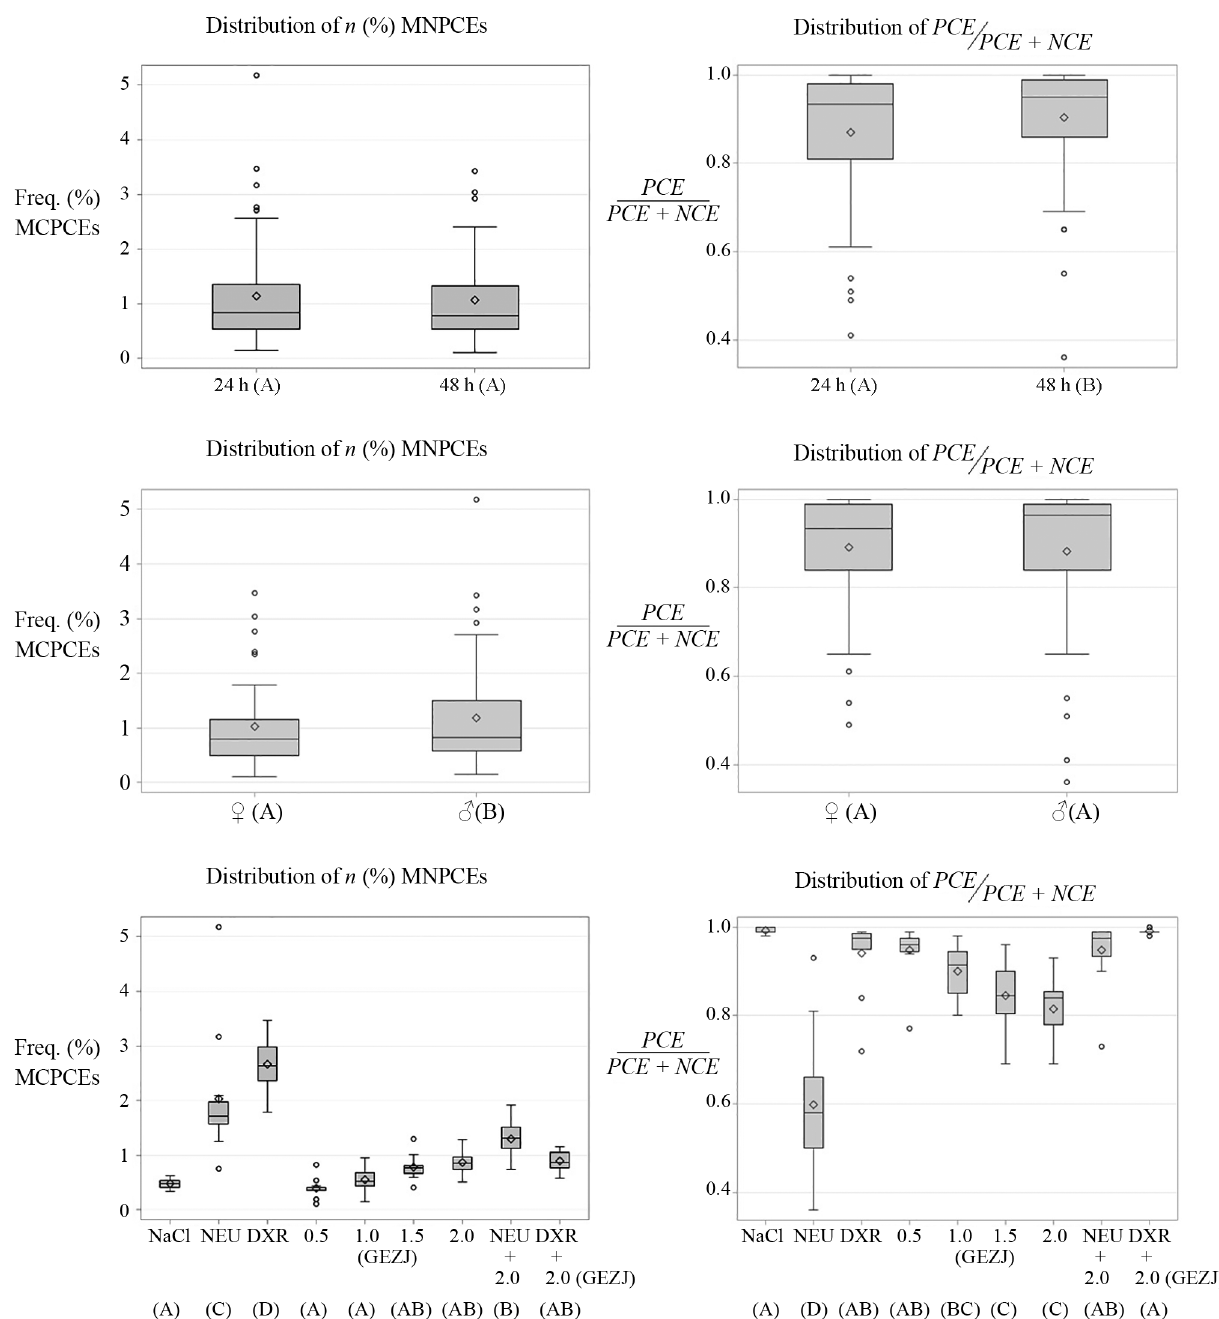
Figure 2 - Box-plots showing the MNPCE frequencies and PCE/NCE ratios in mouse bone marrow in mutagenic and antimutagenic assays of Z. joazeiro bark. Means with different letters are significantly different (p (cid:6) 0.05). NaCl - control group treated with 150 mM NaCl, NEU - N-nitroso-N-ethylurea (50 mg.kg -1 ), DXR - doxorubicin hydrochloride (5 mg.kg -1 ), GEZJ - Glycolic extract of Z. joazeiro Mart. bark (0.5-2 g.kg -1 ), GEZJ (2 g.kg -1 ) + NEU (50 mg.kg -1 ) and GEZJ (2 g.kg -1 ) + DXR (5 mg.kg -1